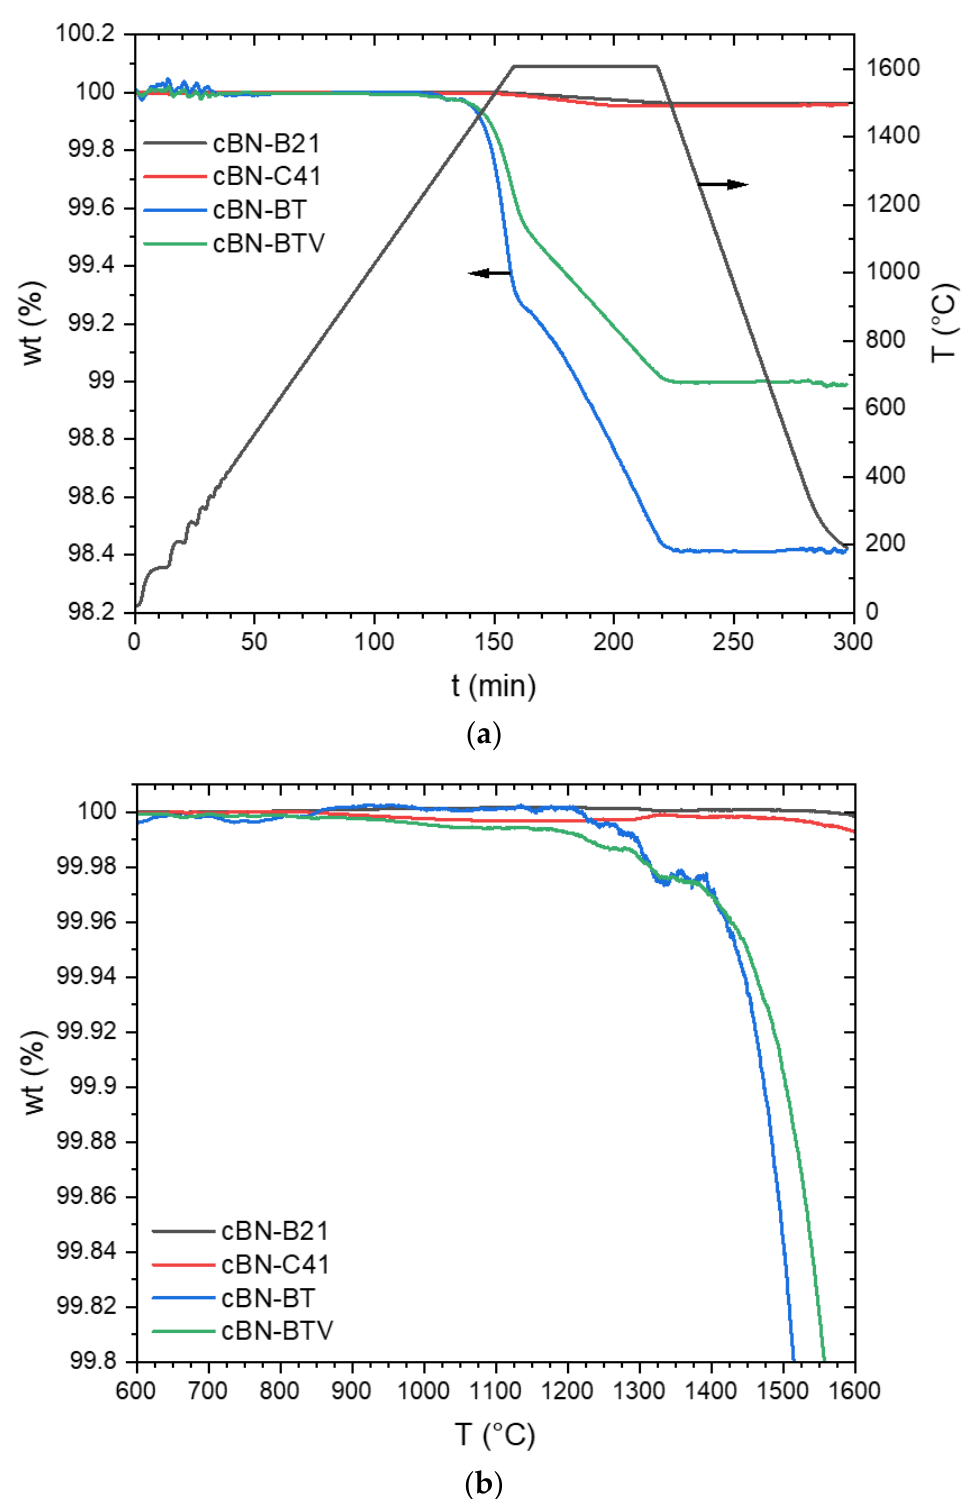
Figure 5. ( a ) Mass loss during the thermogravimetric analysis of the cBN powders B21, C41, BT and BTV under argon atmosphere and ( b ) mass loss as a function of temperature of the same (data of Figure 5a).